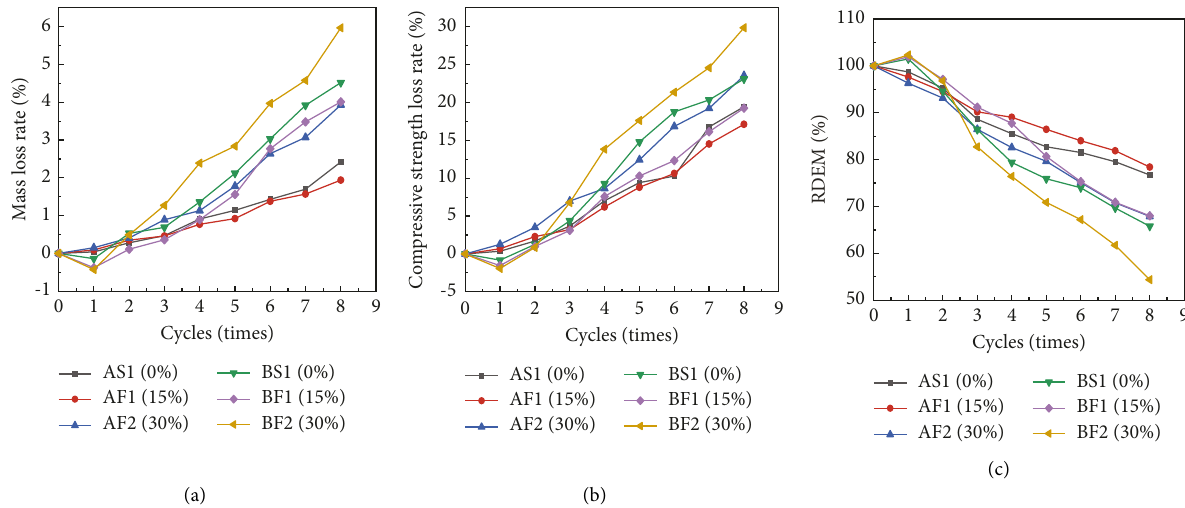
Figure 3: Variation curves of macro-indices of concrete with different fly ash content (A: water; B: compound salt solution). (a) Mass loss rate. (b) Compressive strength loss rate. (c) RDEM.